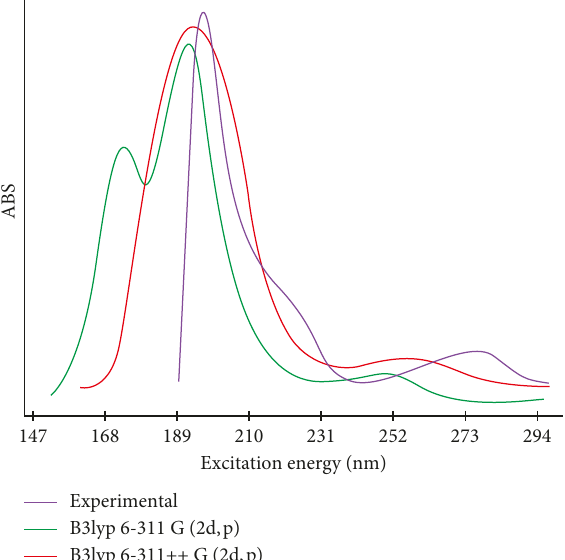
Figure 5: Comparison between experimental and theoretical UV spectra of 4NRC at B3LYP 6-311G (2d,p) and B3LYP 6-311G++ (2d,p) in